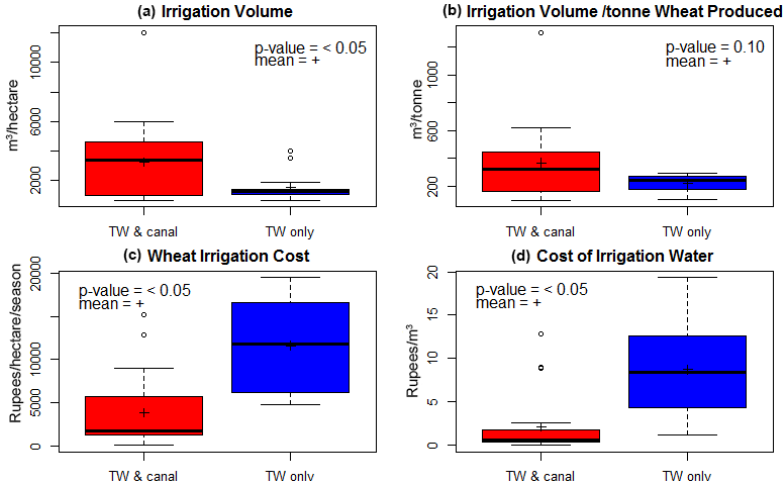
Figure 6. Differences in irrigation practices between tube well and canal users and canal-only users in the district of Jalaun, northern India. The boxplots represent variability between farmers in each district. The boxes represent the 25 to 75 percentiles; the whiskers represent 1.5 times the interquartile range (IQR). The P values give the chance of equal mean obtained from Student’s t